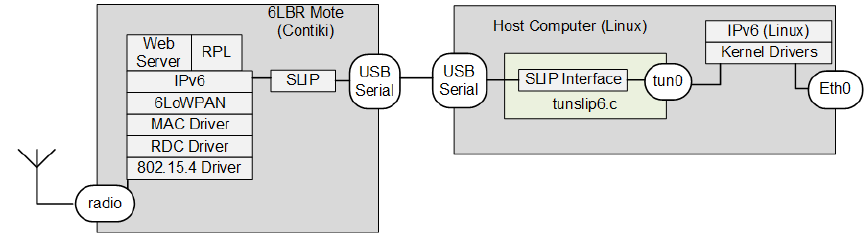
Figure 11. 6LBR in a mote connected to a Linux host. tun0, tunnel